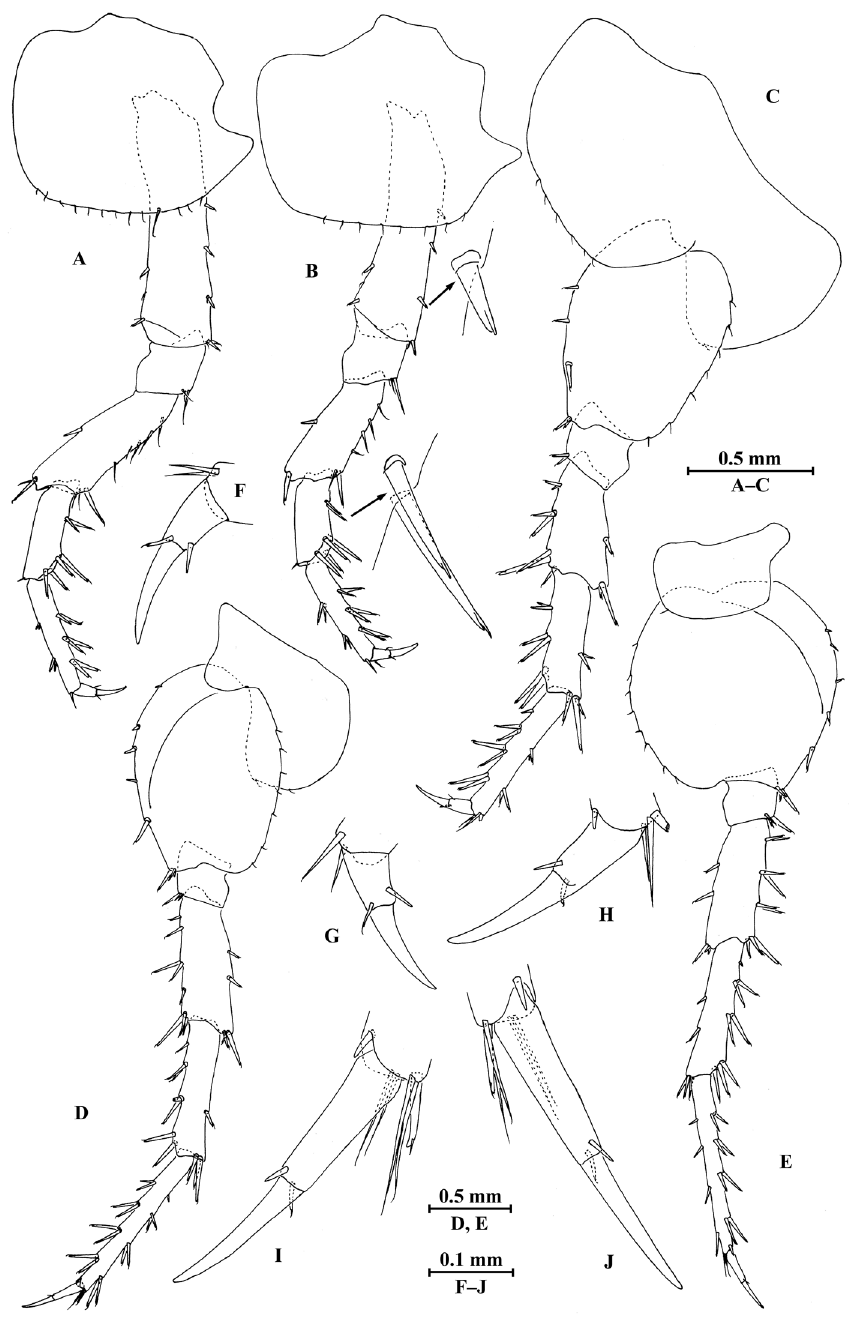
Figure 4. Myanmarorchestia peterjaegeri Hou, sp. n., female holotype. A pereopod III B pereopod IV C pereopod V D pereopod VI E pereopod VII (right) F dactylus of pereopod III G dactylus of pereopod IV H dactylus of pereopod V I dactylus of pereopod VI J dactylus of pereopod